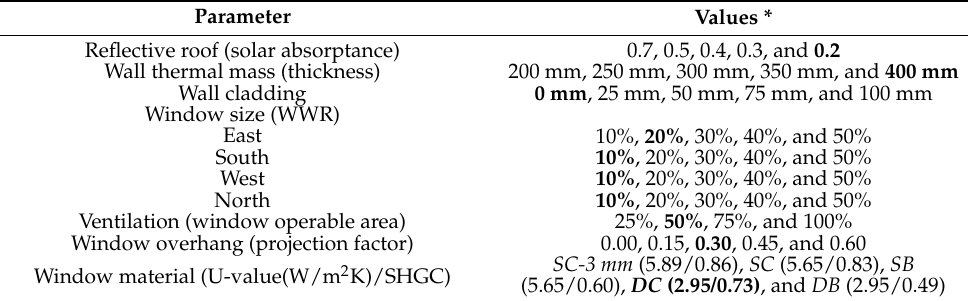
Figure 8. Multiple parameter optimization and the reduction in the percentage of operative tempera- tures outside the adaptive comfort zone during nighttime hours. Table 5. Optimal value for each of the analyzed design